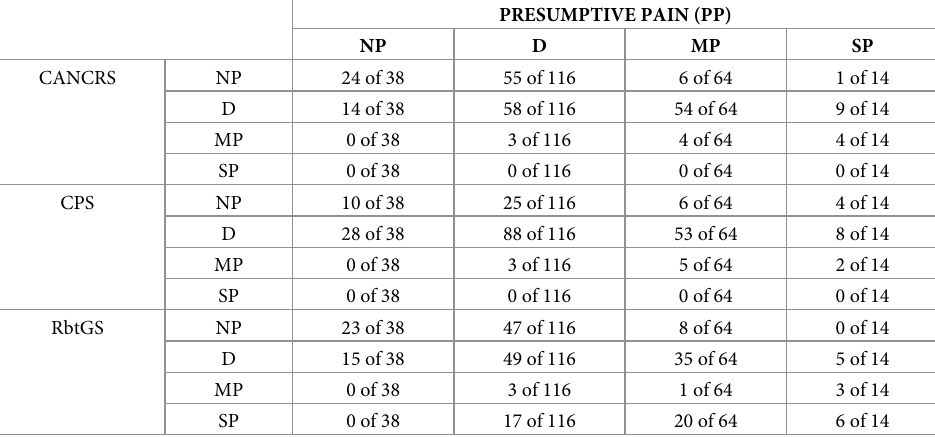
Table 5. Results for CANCRS, CPS and RbtGS compared to